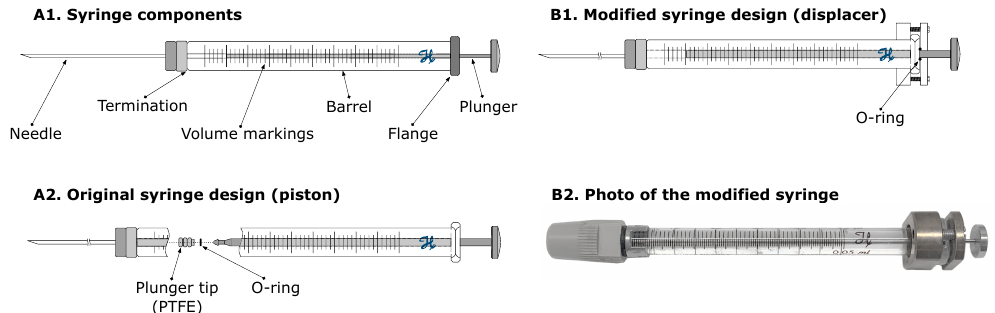
Figure 4. Left : Typical construction of a syringe which works according to the piston principle. Right : Modified syringe that works according to the displacer principle. In the first case, the ID of the barrel determines the flow rate; in the second case, the OD of the plunger.